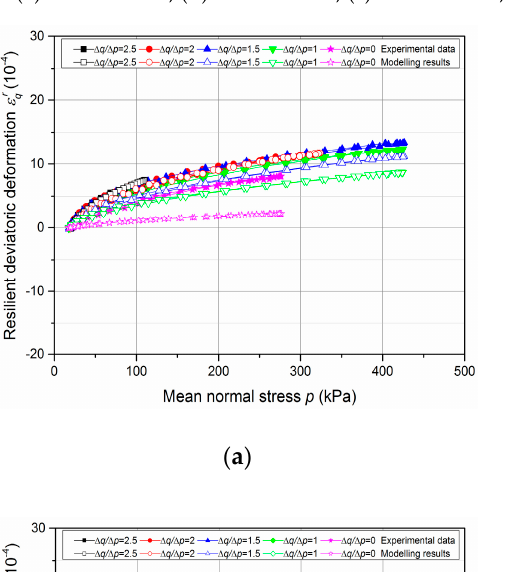
Figure 21. Modelling of ε vr based on Equations (12)–(15) for UGM Bréfauchet at different water content: ( a ) T6- w = 3.5%; ( b ) T5- w = 4.2%; ( c ) T7- w = 4.3%; ( d ) T8- w = 4.6%.